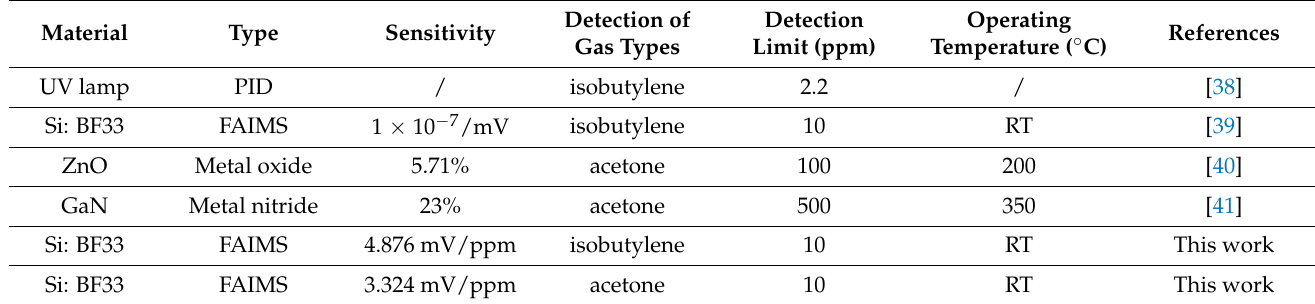
Table 3. Comparison of recently published VOC sensors with FAIMS-VOC